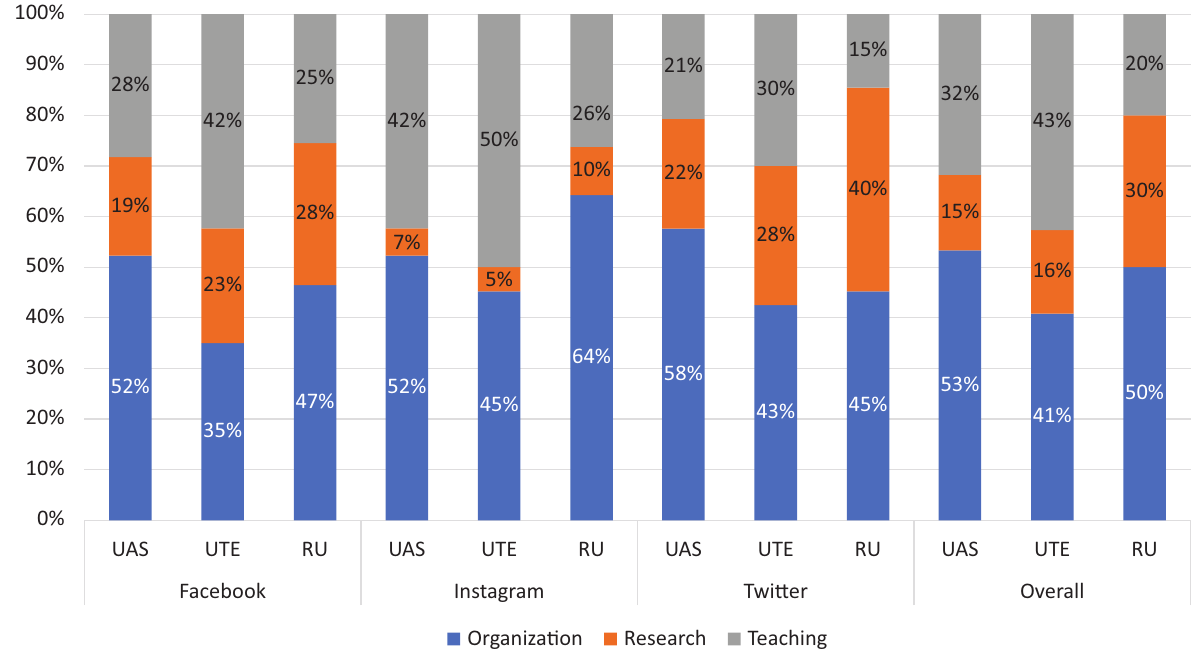
Figure 4. Topics mentioned in social media posts by Swiss HEIs on Facebook, Instagram, and Twitter ( n = 4,500). Note: UAS = universities of applied sciences; UTE = universities of teacher education; RU = research universities.